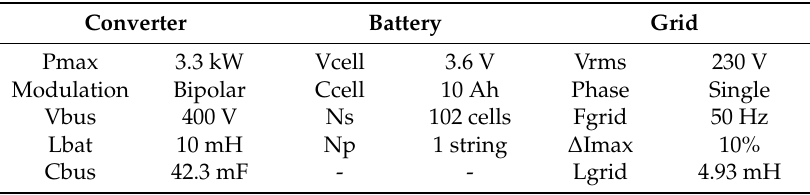
Table 6. Main characteristics of the Light-Duty system connected to HV